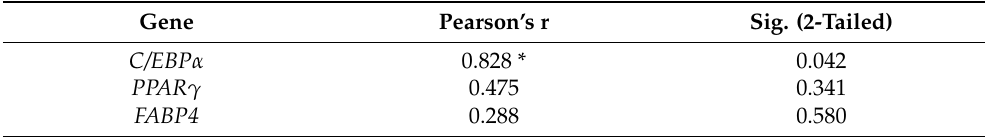
Table 3. Pearson correlation analyses between the expression of HOXA11 and fat-development- associated genes in differentiation of adipocytes.